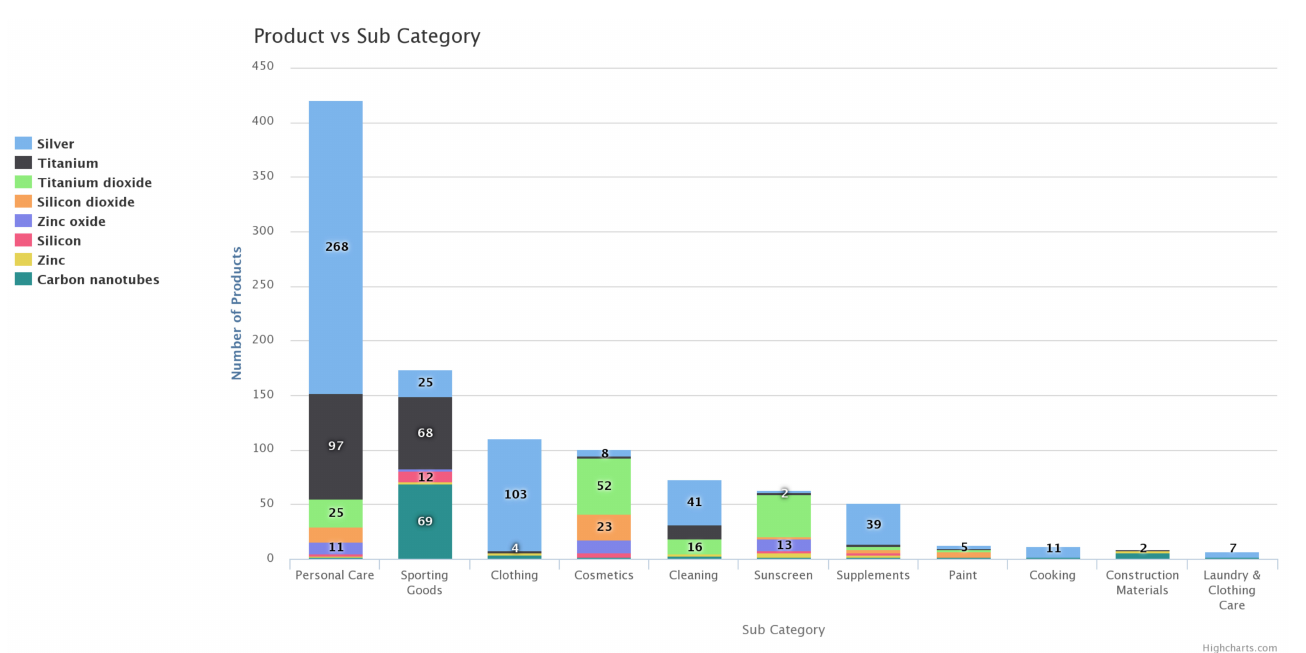
Figure 2. The incorporation of nAg, nTiO 2 , nZnO and nSiO 2 in various nano-enabled products’ (NEPs) categories